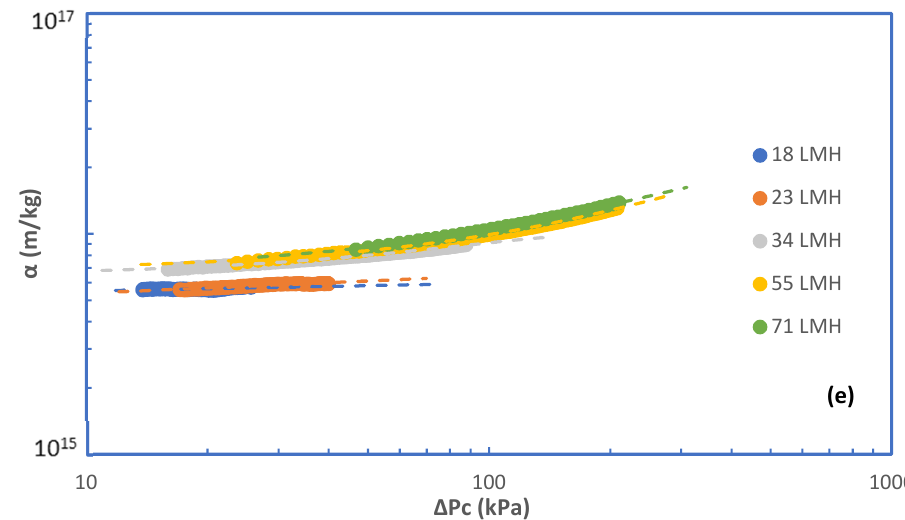
Figure 4. Specific cake resistance α versus pressure drop due to fouling ΔP c . Fouling species: ( a ) 100% SA, ( b ) 100% BSA, ( c ) 25% SA-75% BSA, ( d ) 50% SA-50% BSA, ( e ) 75% SA-25% BSA.